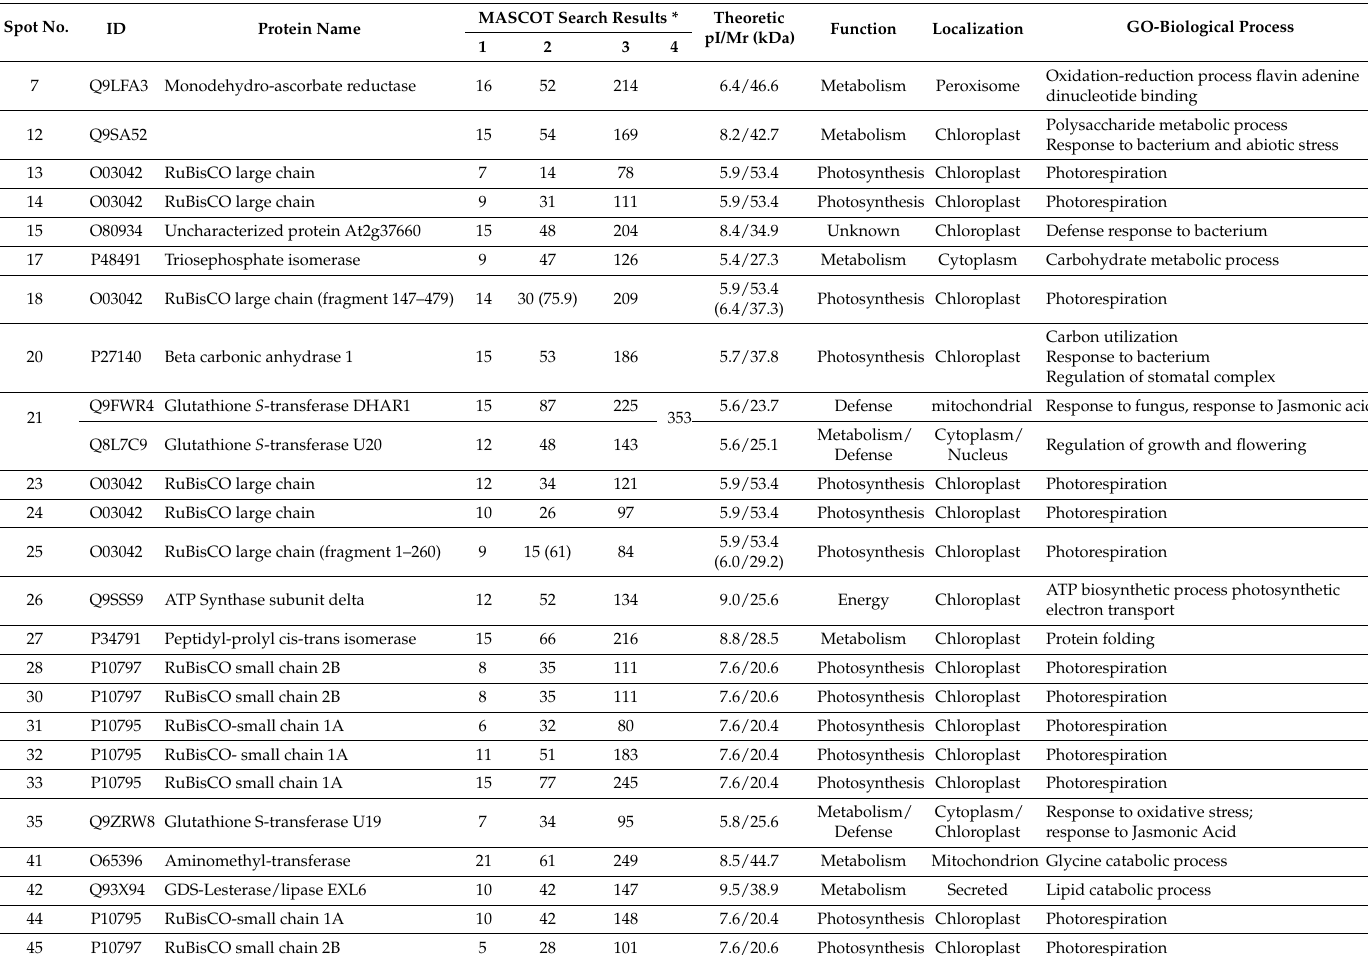
Table 1. Down-expressed proteins in cerato-platanin (CP)-treated leaves after 2D electrophoresis and MALDI-ToF MS analysis. Spot